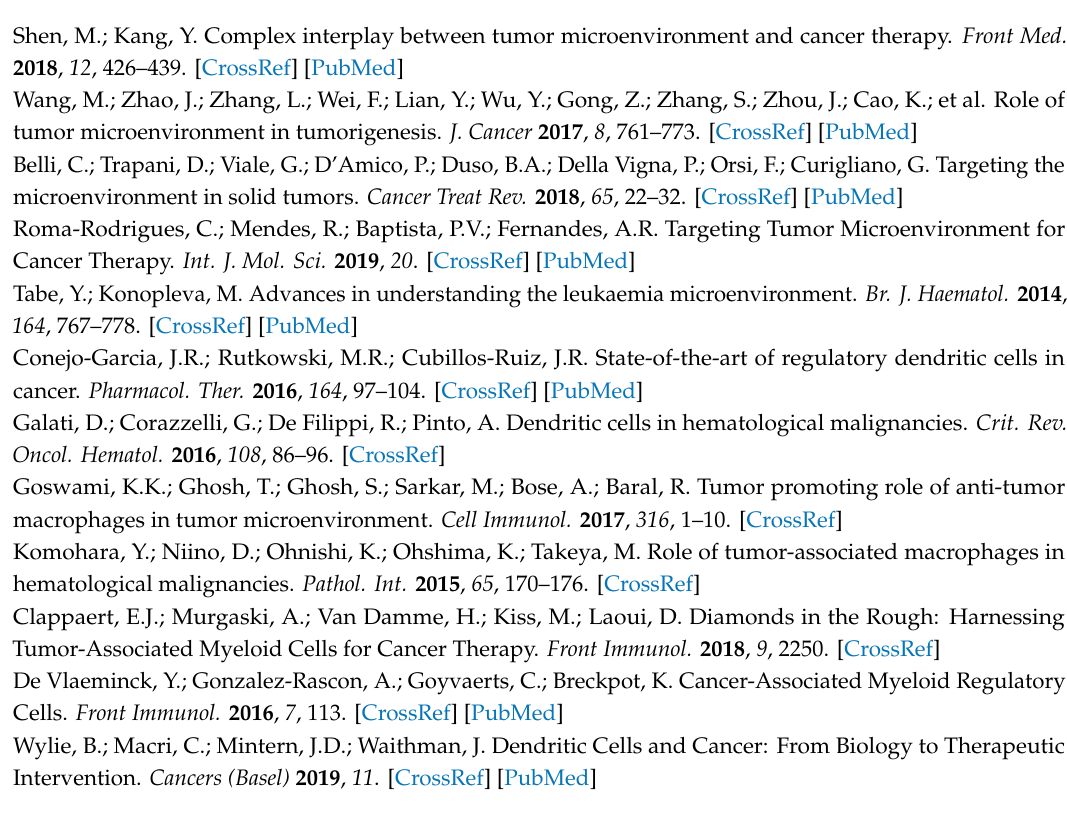
Figure S1: Phenotypic analysis of DCs and MØs di ff erentiated in the absence or presence of conditioned media from ALL cells, Figure S2: Representative histograms showing the allostimulatory capacity of DCs di ff erentiated in the absence or presence of conditioned media from ALL cells, Figure S3: Conditioned media from di ff erent ALL cell lines alter the di ff erentiation of DCs and